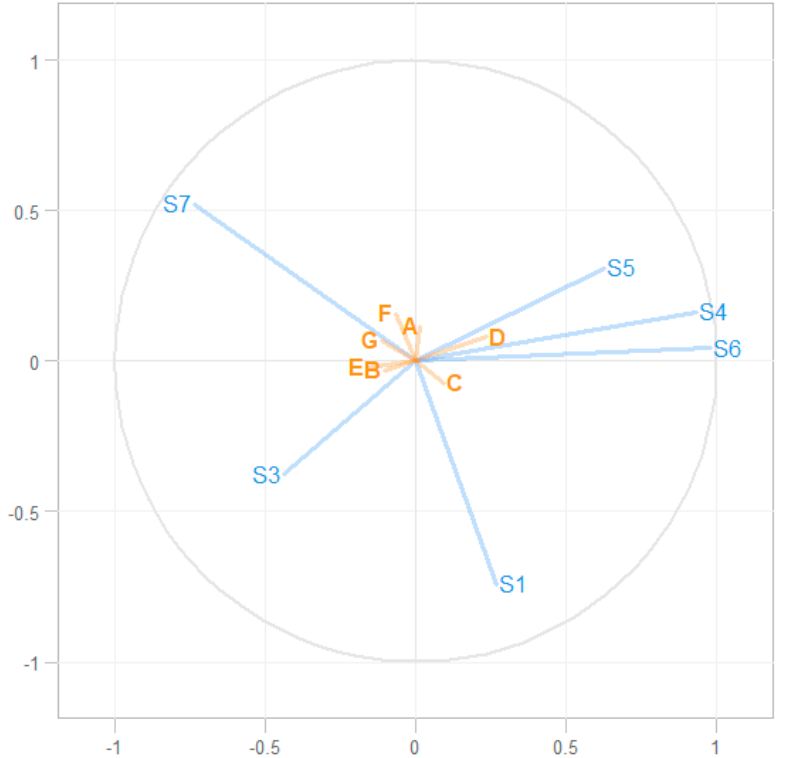
Figure 2. Association between the eNose sensor data and target VOCs. In blue: the six eNose sensors included in the two-way orthogonal partial least square regression (O2PLS) modelling (numbered). In orange: thesevenpulmonaryoxygentoxicity(POT)-relatedexhaledvolatileorganiccompounds(VOCs);